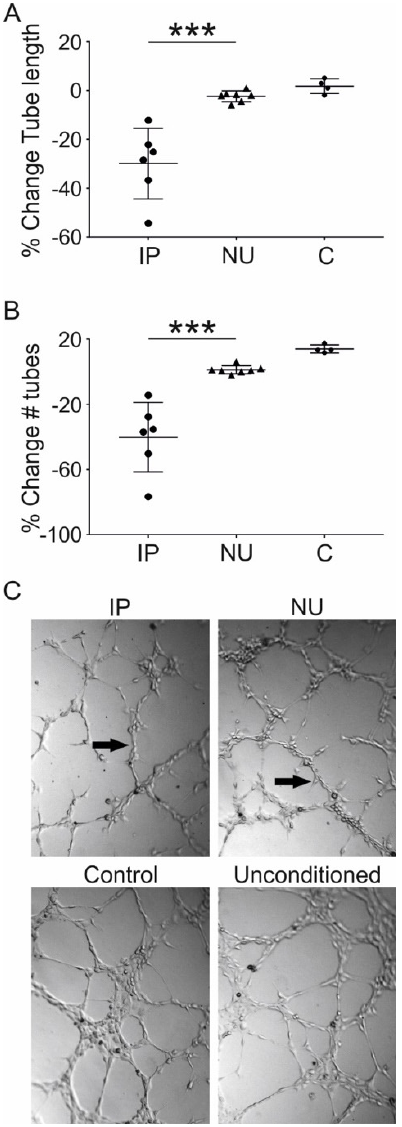
Figure 5. MSC from induced periosteum inhibit early in-vitro angiogenesis. Angiogenesis measured by total tube length ( A ) and total number of tubes ( B ) shows a significant inhibitory effect of media conditioned by MSCs originating from induced periosteum (IP) compared with non-union (NU) and positive control human umbilical vein endothelial cell (HUVEC) endothelial cell growth media ( C ). Values are normalised to unconditioned MSC growth media and the number of MSCs is counted at the end of the conditioning period. Photomicrographs showing representative examples of tube formation in induced periosteum, non-union, HUVEC control, and unconditioned media treated wells ( C ). All data IP ( n = 6), NU ( n = 7), C (four technical replicates). *** denotes p ≤ 0.001.